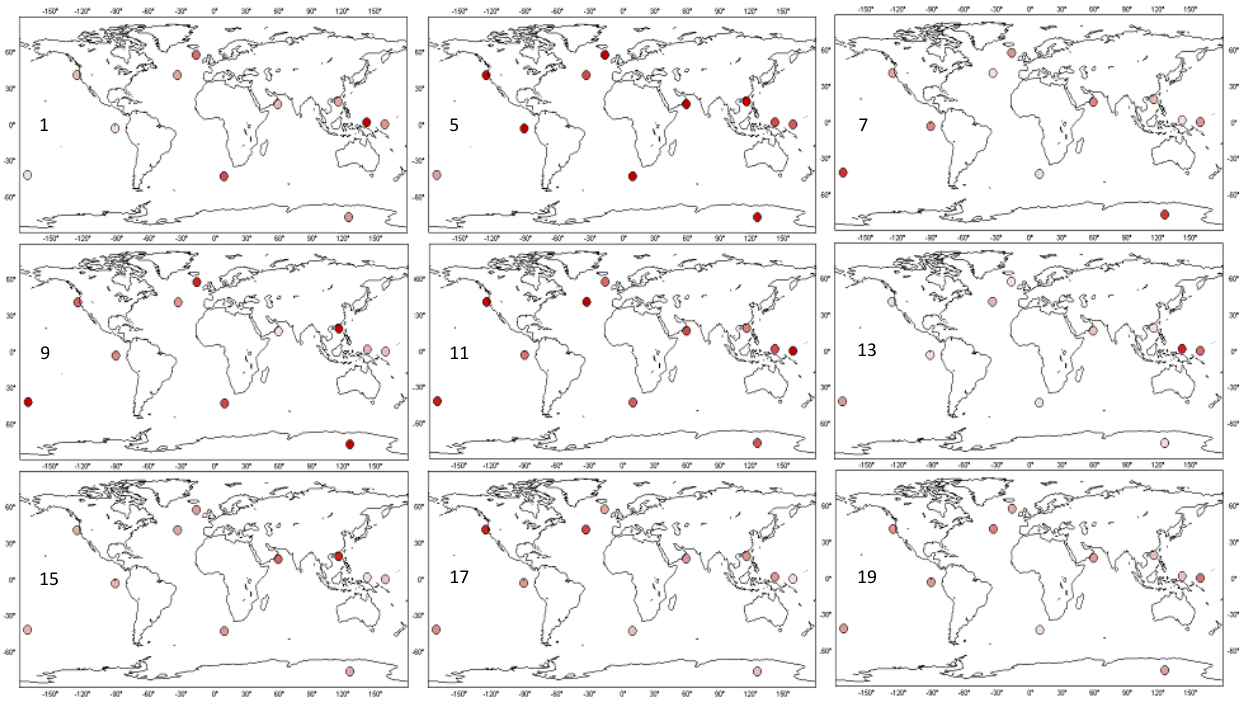
Fig. 6. Maps of peak interglacial sea surface temperature (SST) and EDC temperature for MIS 1-19. In the colour scale, the darkest red reflects the highest SST and the lightest the lowest